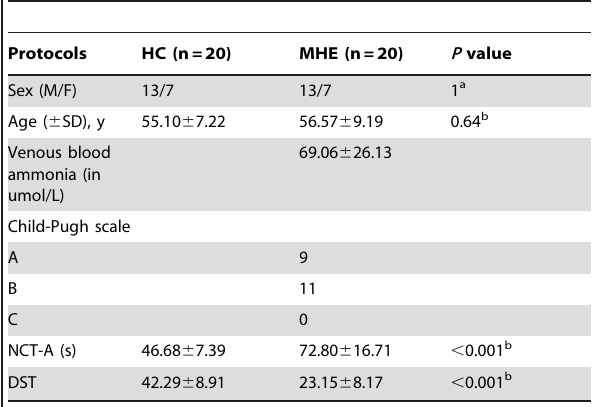
Table 1. Demographics and clinical data of MHE patients and healthy